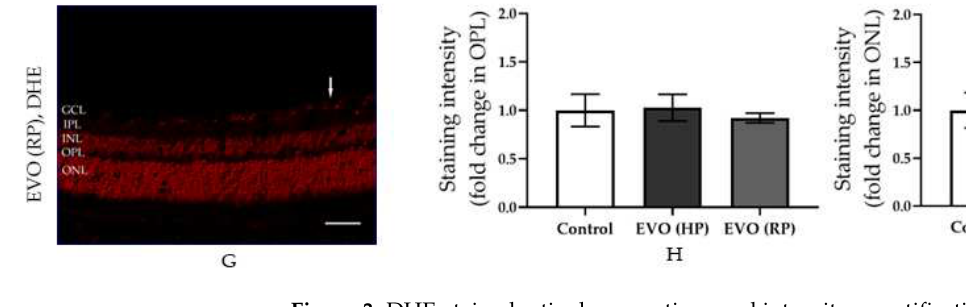
Figure 3. DHE-stained retinal cryosections and intensity quantification for individual retinal layers. ( A , D , G ) show the DHE-stained retinal cryosections in the control, EVO (HP), and EVO (RP) groups, respectively. ( B , C , E , F , H , I ) show the staining intensity quantified from vessels, GCL, IPL, INL, OPL, and ONL, respectively. The white arrows point to retinal blood vessels. GCL: ganglion cell layer; IPL: inner plexiform layer; INL: inner nuclear layer; OPL: outer plexiform layer; ONL: outer nuclear layer. EVO: episcleral vein occlusion; HP: high intraocular pressure; RP: recovered intraocular pressure. Control group refers to sham group. Values are expressed as mean ± SEM (* p < 0.05; n = 5–6 per group, scale bar = 50 μm). 3.4. Elevated IOP Reversibly Increased the Expression of NOX2 in the Retina The immunoreactivity of NOX2 was increased in retinal vessels and the ganglion cell layer in the EVO (HP) group (Figure 4C–F). However, this overexpression of NOX2 nor- malized four weeks after IOP normalization, as is shown in the staining of the EVO (RP) group (Figure 4C,D,I,J).